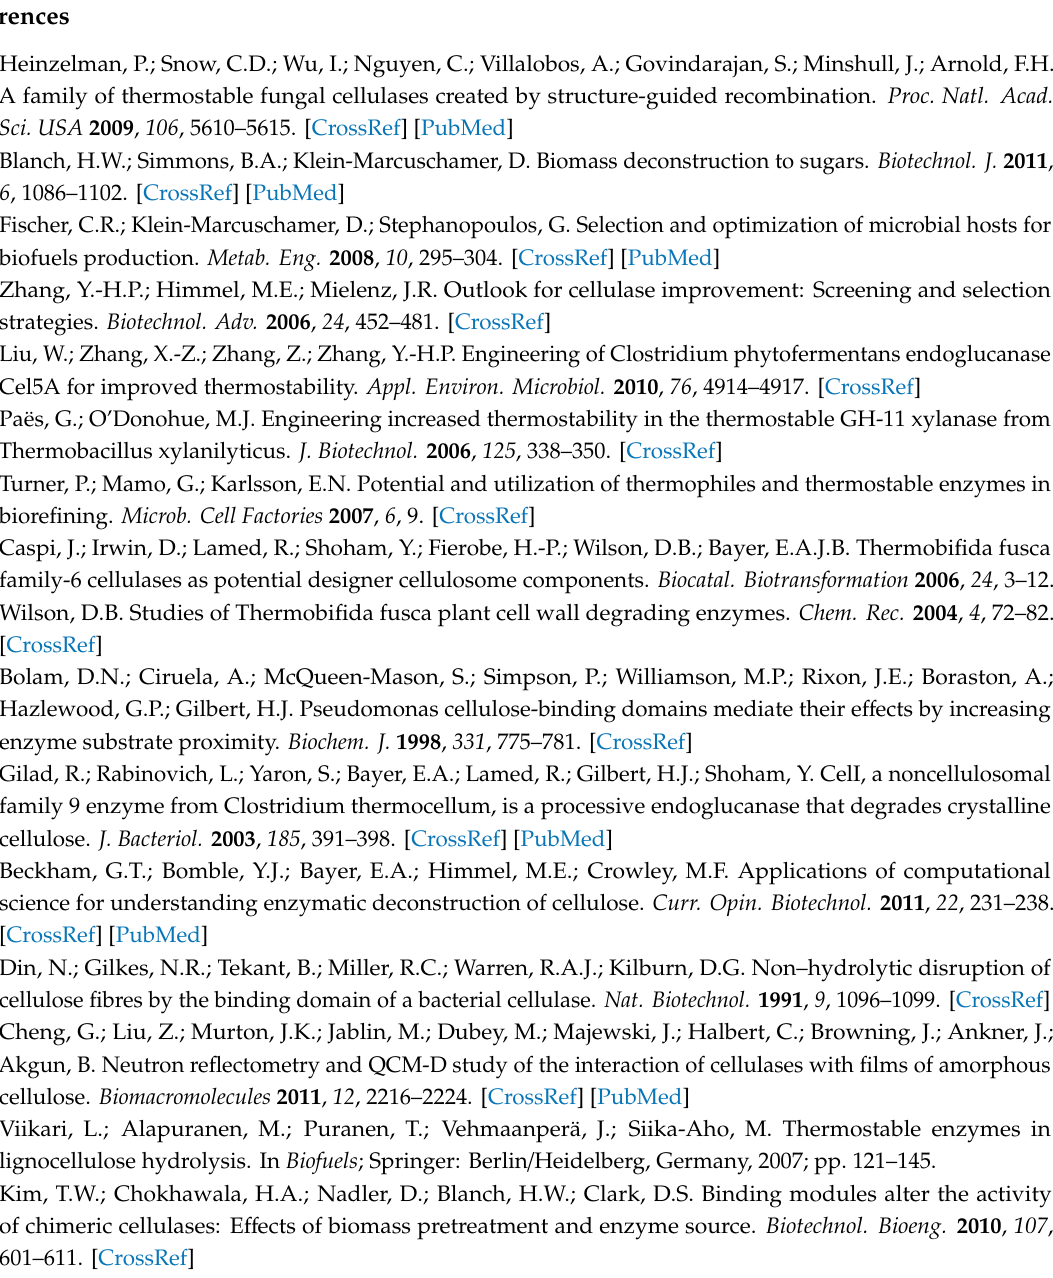
Figure S1: Schematic representation of engineering of T. fusca endoglucanase cel6A; Figure S2: Schematic representation of T. fusca endoglucanase cel6A modular architecture; Figure S3: Agarose (0.8%) gel showing restriction maps generated by digestion of pcel6A.C, pcel6A.BC, pcel6A.BCB, pcel6A.CBC, and pcel6A. Table